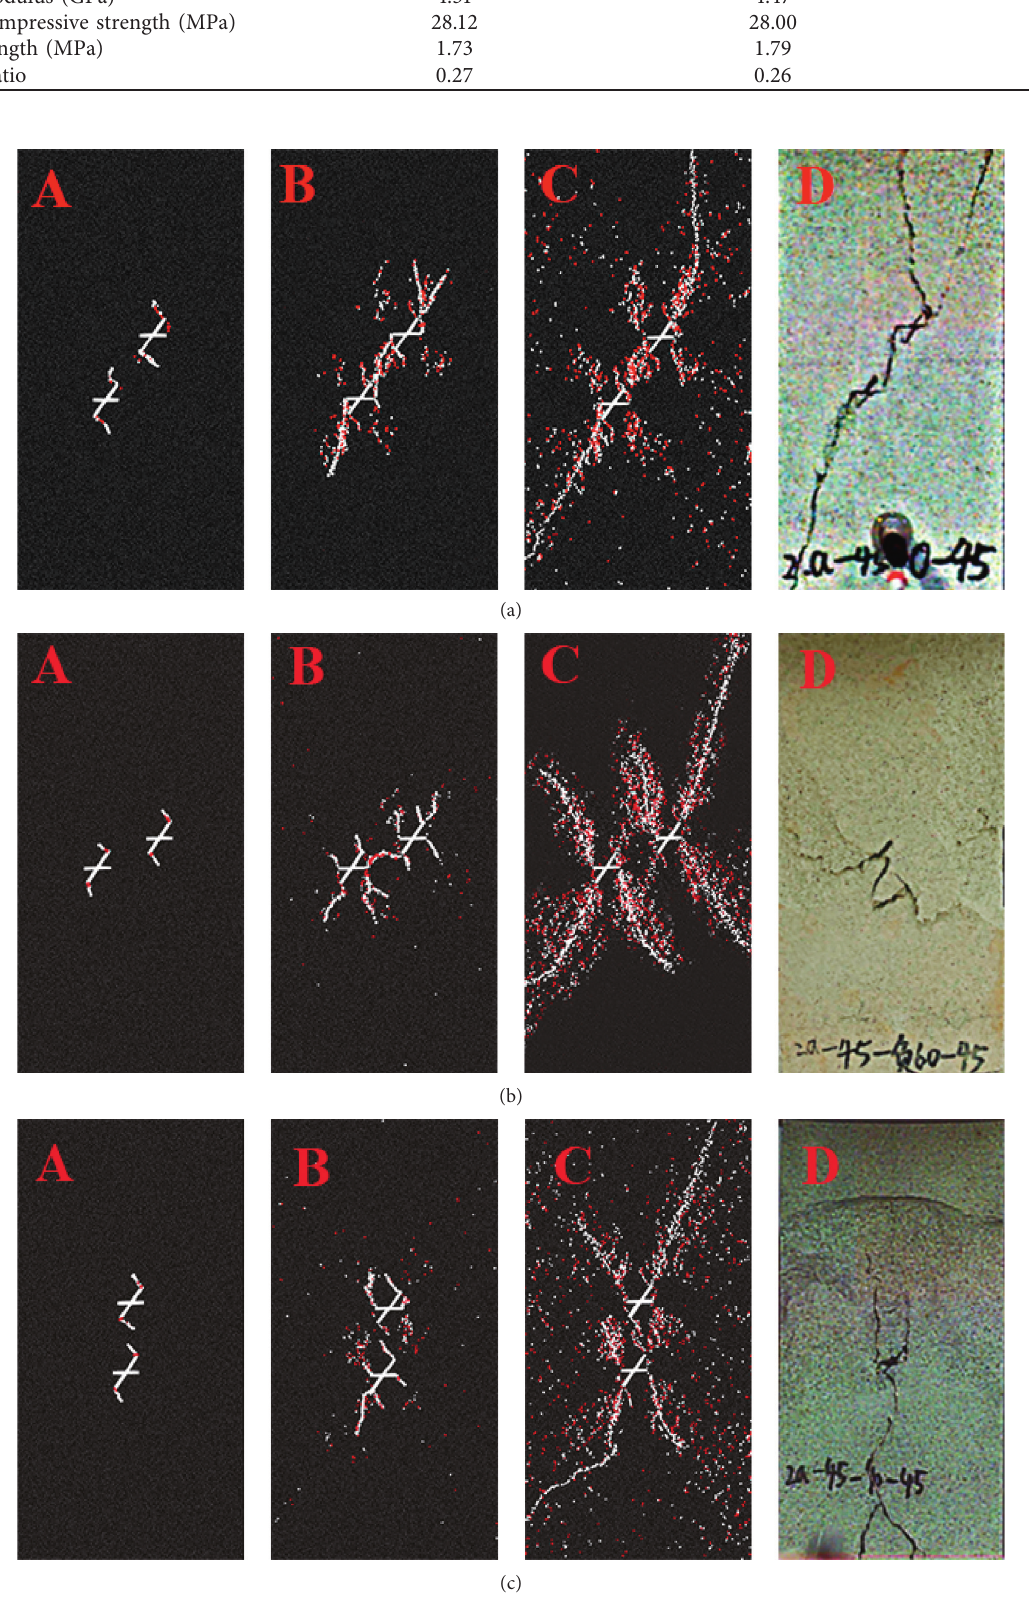
Figure 10: Figures of the crack propagation process in the FJM model (red and white colors indicate shear and tensile cracks, respectively) and experiments for β . (a) β � − 60 ° . (b) β � 0 ° . (c) β � 90 °